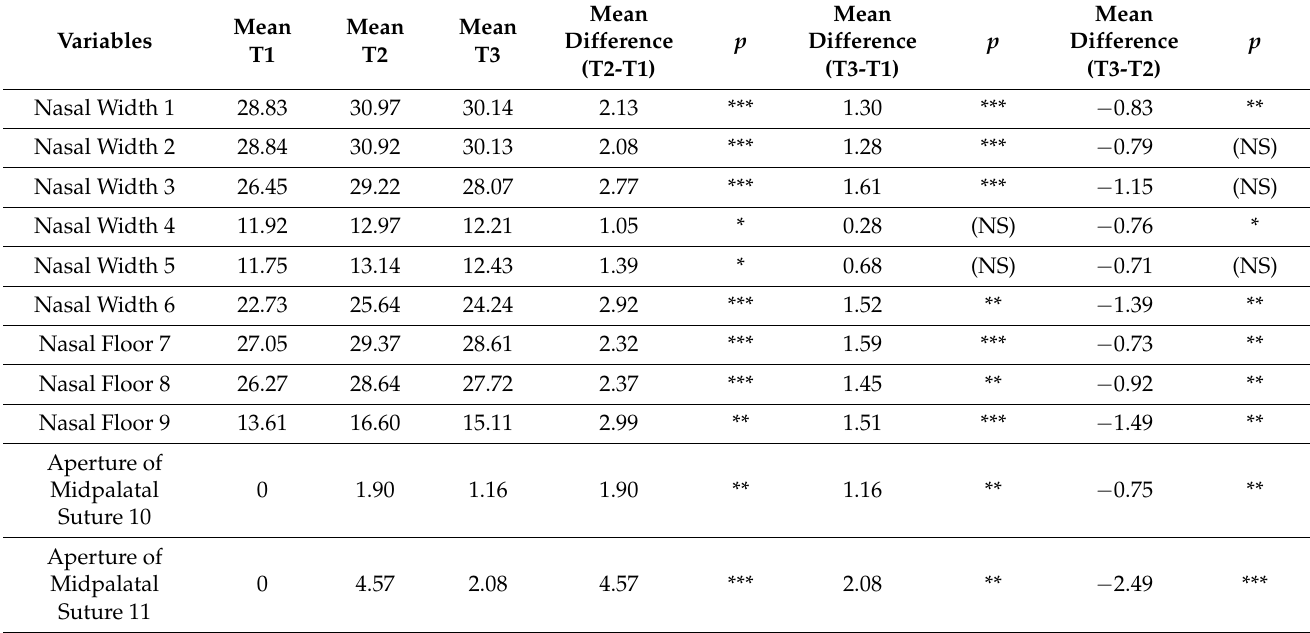
Table 13. Total outcomes (mm) of the mean values of all the variables and their differences in the three time